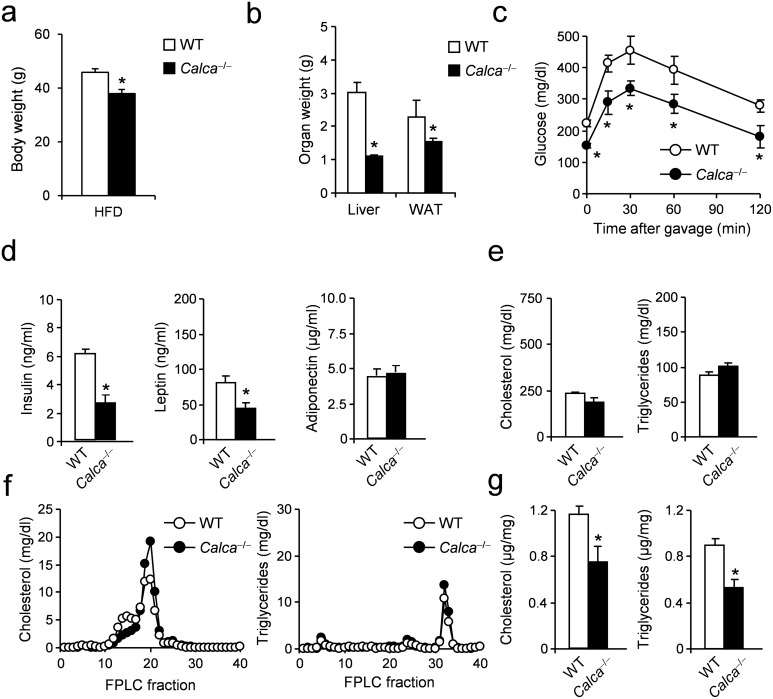
Effects of DIO on metabolic parameters in mice lacking Calca.(a) Body weight in Calca-deficient mice and controls fed HFD for 16 weeks. (b) Organ weights (epididymal WAT, white adipose tissue) after 16 weeks of feeding. (c) Plasma glucose concentrations during OGTT (1 g/kg) following a 4h fasting period in Calca-deficient mice and controls after 16 weeks of feeding. (d) Plasma levels of insulin, leptin and adiponectin in the same mice. (e) Total plasma cholesterol and triglycerides concentrations in the same mice. (f) Cholesterol and triglycerides FPLC profile from pooled plasma (n>8) in Calca-deficient mice and controls fed HFD for 16 weeks. (g) Total hepatic cholesterol and triglycerides concentrations in Calca-deficient mice and controls fed HFD for 16 weeks. Results are shown as means ± SEM (n = 8–10). *P < 0.05.